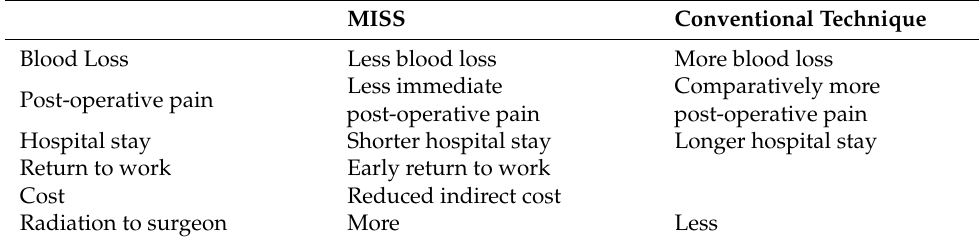
Table 4. Advantages of minimally invasive spine surgery (MISS) over conventional surgery.